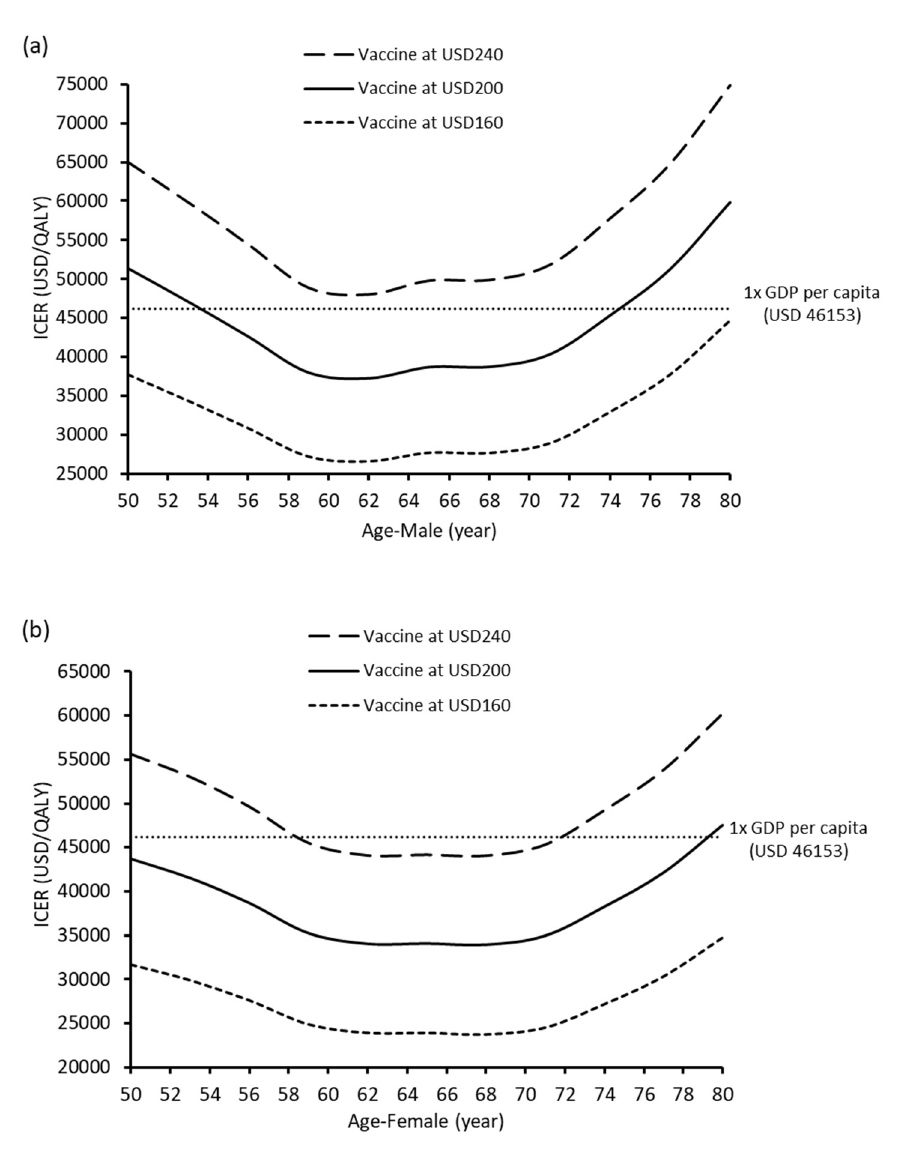
Fig 4. Change of incremental cost-effectiveness ratio (ICER) of HZ/su against vaccination age at three vaccine costs in (a) males and (b) females.